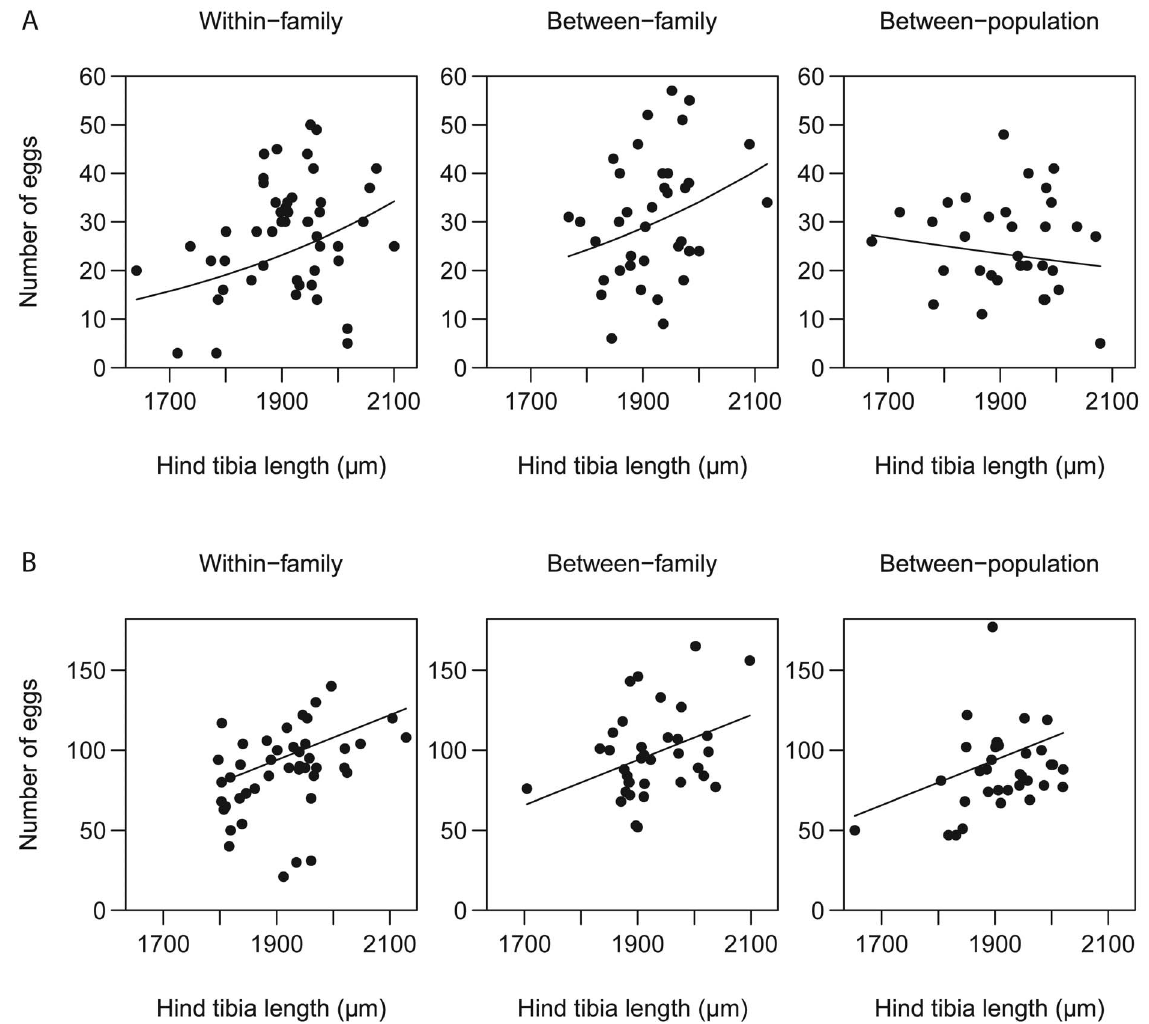
Figure 3. Egg load (A) at emergence and (B) at death as a function of body size for the three cross types. Circles represent observed values and lines represent the predictions of the fixed part of the model with cross type, body size and their interaction as fixed effects and maternal and paternal families as random effects for egg load at emergence, body size as fixed effect and maternal families and block as random effects for egg load at death.